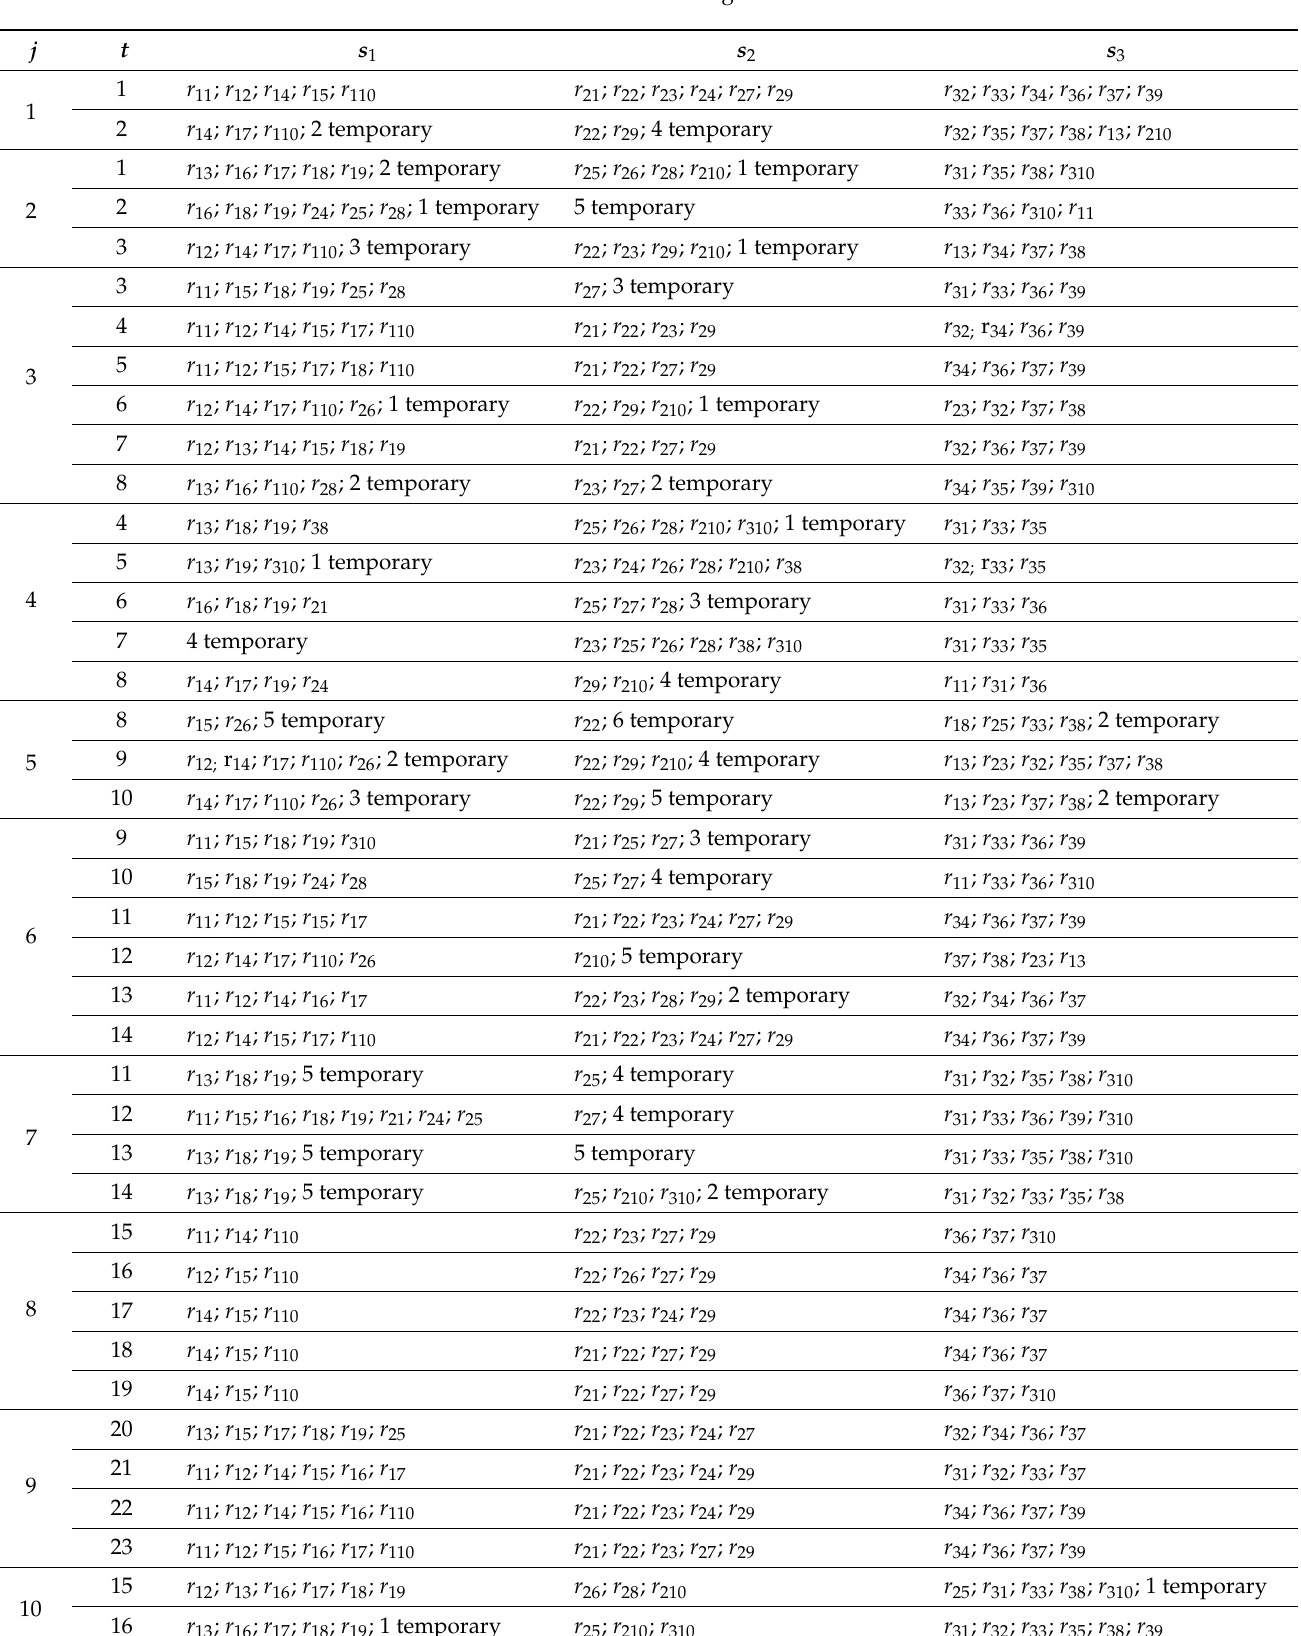
Table 4. Multi-skilled resource scheduling of scheme